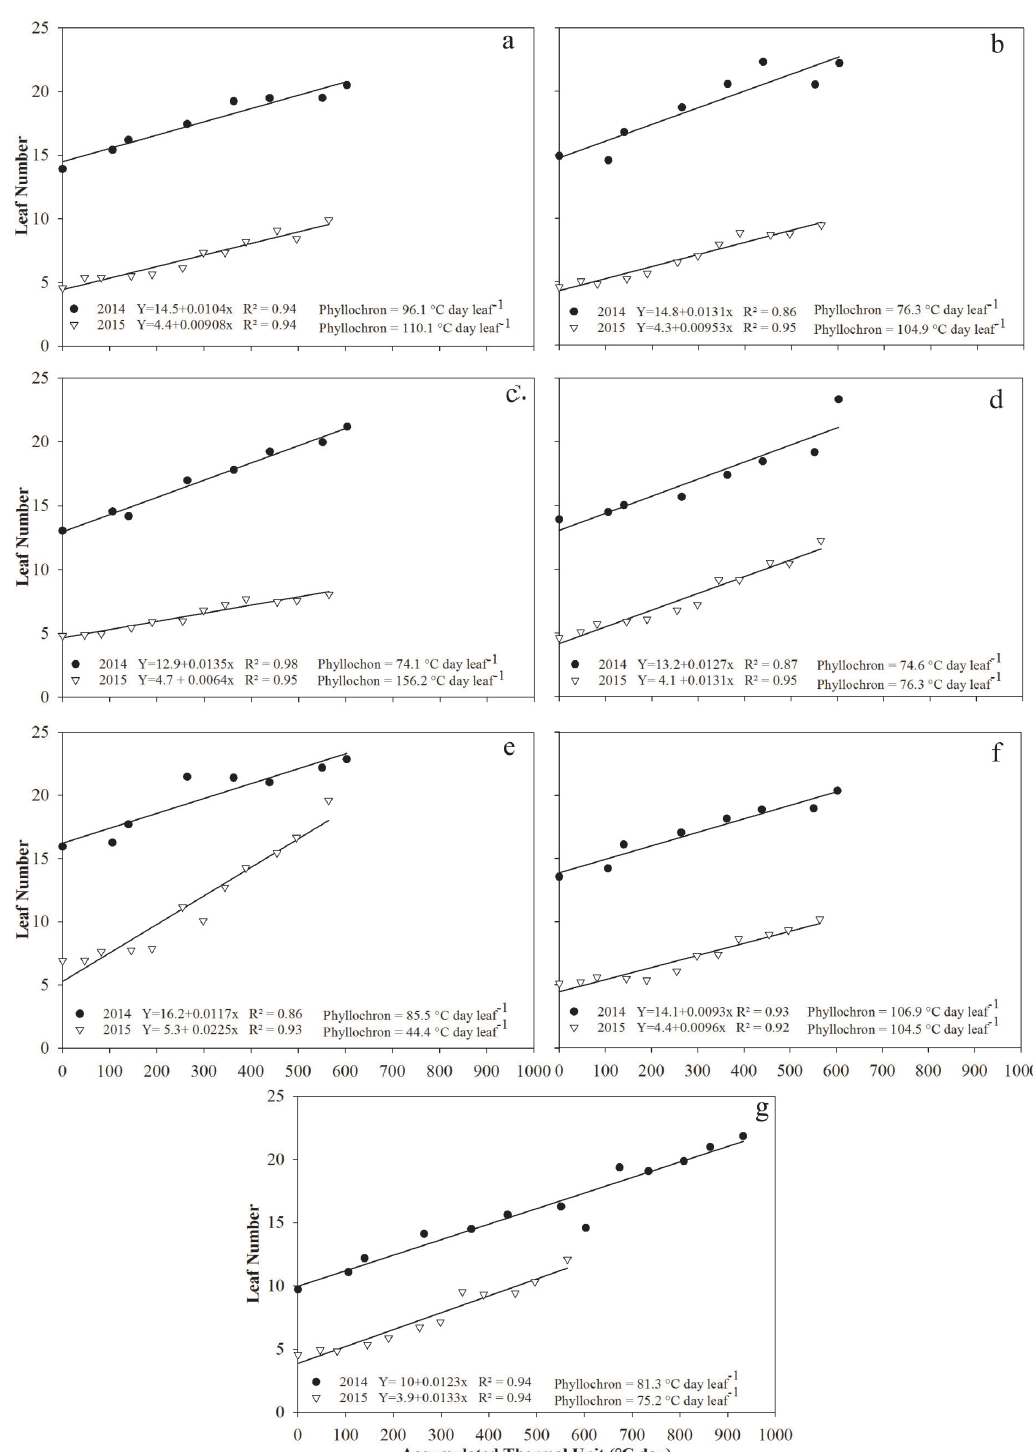
Figure 5 - Phyllochron (°C day leaf -1 ) of dual-purpose wheat cultivated in different cropping systems: S.parahyba Intercrop-I (a) ; P.rigida Intercrop-I (b) ; P.dubium Intercrop-I (c) ; P.dubium Intercrop-II (d) ; Monoculture (e) ; Eucalyptus Intercrop-II (f) ; Eucalyptus Intercrop-I (g)